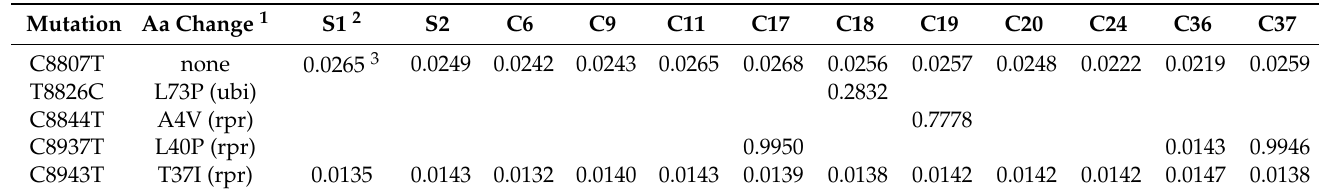
Table 2. Mutations detected at >1% frequency in MRE/rprORF stock virus and infected mosquito